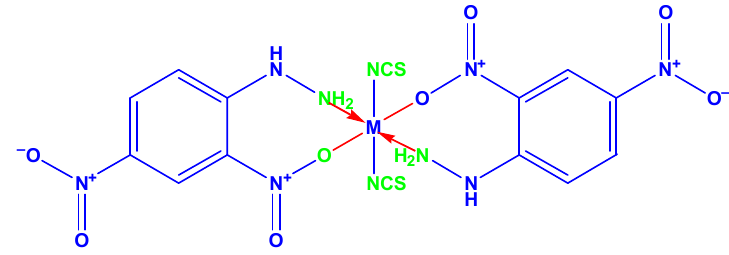
Figure 1. Structures of the metal complexes (M = Co(II) and Ni(II)).